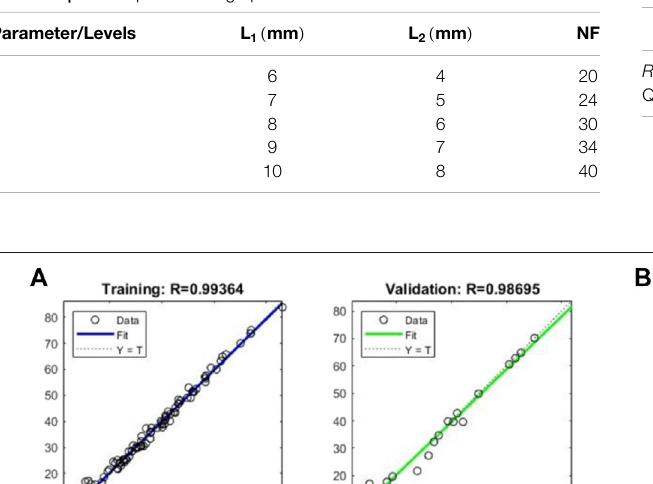
TABLE 3 | The measures of the performance analysis of the prediction